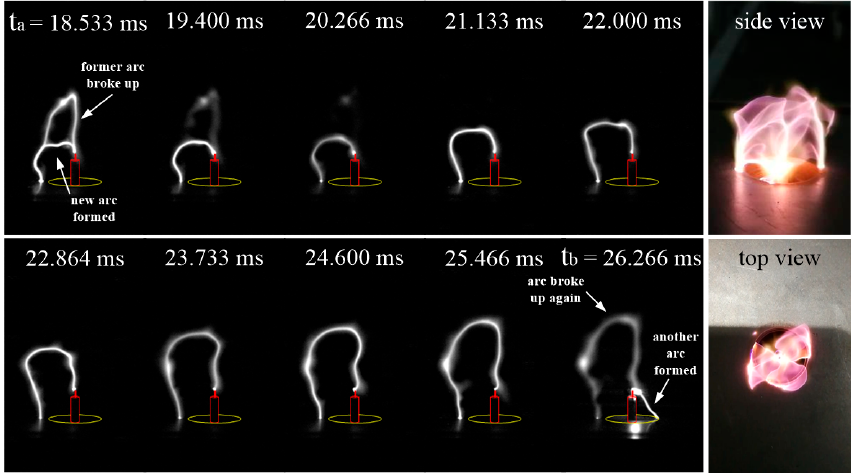
Figure 5. ( a ) Voltage, current, and power waveforms of the gliding arc discharge when average flow rate in stable mode was 30SLM. ( b ) Zoomed-in view voltage, current, and power waveforms (from t = 0.0183 s to t = 0.0265 s).